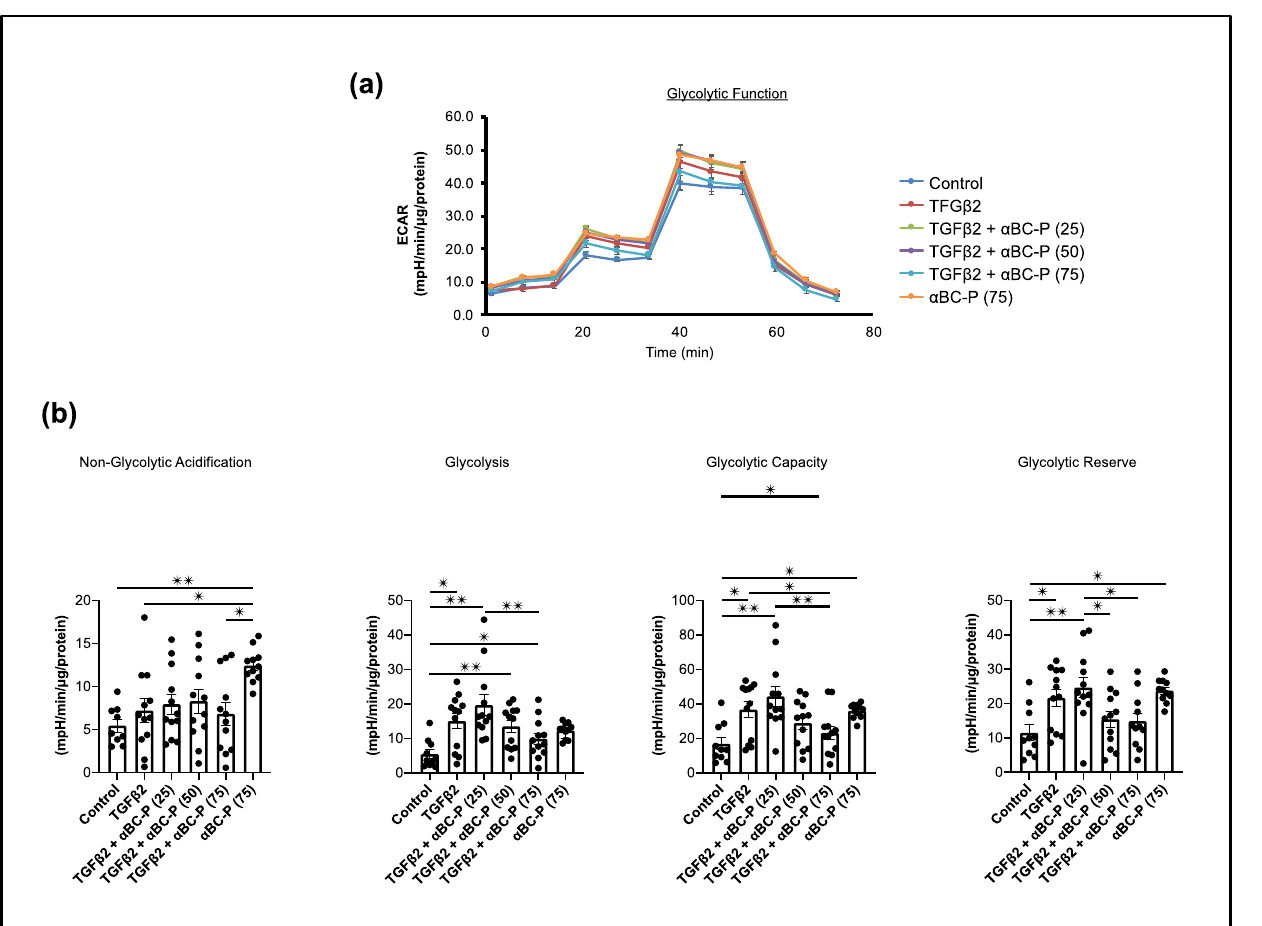
Figure 6. Change in glycolysis in TGF β -induced EMT in hRPE cells. Real-time monitoring of glycolysis using the Seahorse XFe96 Glycolytic Stress Test Kit for key parameters of the glycolytic function ( a ). TGF β -induced EMT in hRPE cells significantly increased glycolysis, glycolytic capacity, and glycolytic reserve, but only 75 µ g/mL α BC-P significantly suppressed all glycolytic functions ( b ). α BC-P: α B crystallin peptide. N.S.: not significant. Data normalized by total cellular protein. Values are means ± SEM. * p < 0.05, ** p < 0.01. n = 9 – 15.